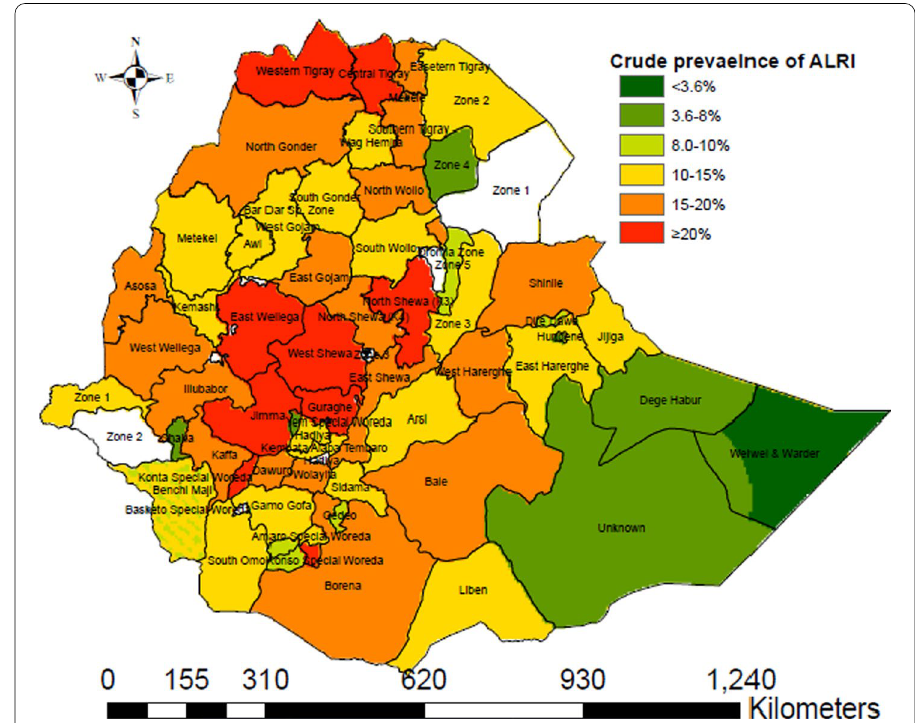
Fig. 3 The crude prevalence of ALRI among under-five children in the Ethiopian administrative